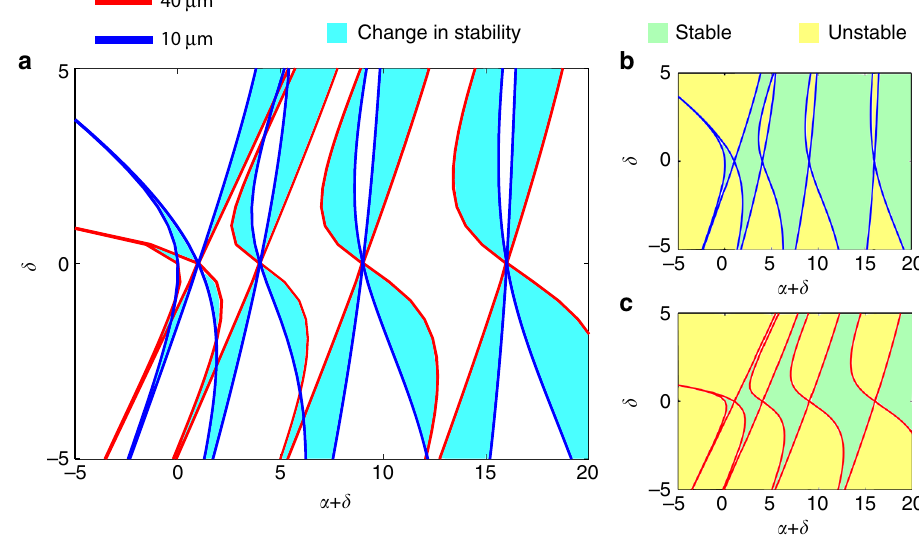
Fig. 8 Theoretical stability diagram for a locally uniform multimode fi ber. a Change in the stability diagram when the fi ber radius is reduced from 40 to 10 µ m. A reduction in the radius of the multimode fi ber shifts the unstable gain regions, thus leading to new spectral lines. b and c are the stability diagrams corresponding to parabolic multimode fi bers with core radii of 40 and 10 µ m, respectively. In all cases, the input spot-size was chosen to be 1.5 times that of the fundamental mode and the input peak power was assumed to be 180 kW. The parameters α and δ are de fi ned as α ¼ a 2 0 wavelength. The parameters E 0 and w 0 are fully determined from the initial conditions with the former denoting the initial electric fi eld amplitude and the latter representing the input beam spot- size. The function f ( z ) = 1/ w 2 ( z ) corresponds to the beating behavior of light during propagation, where w (z) denotes the local beam spot-size. The associated stability diagram (Fig. 8a) and the corresponding gain regions can then be obtained using Floquet theory.